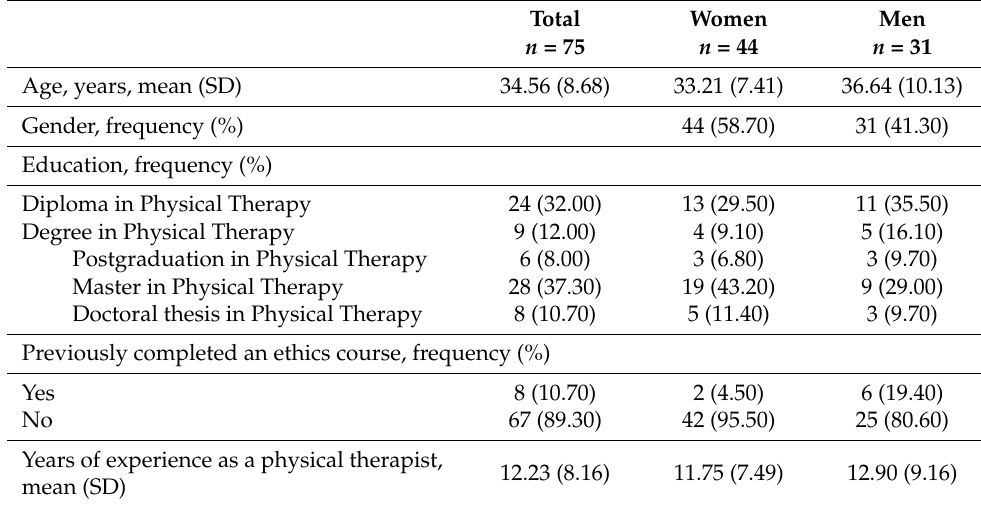
Table 1. Sociodemographic characteristics of the sample.